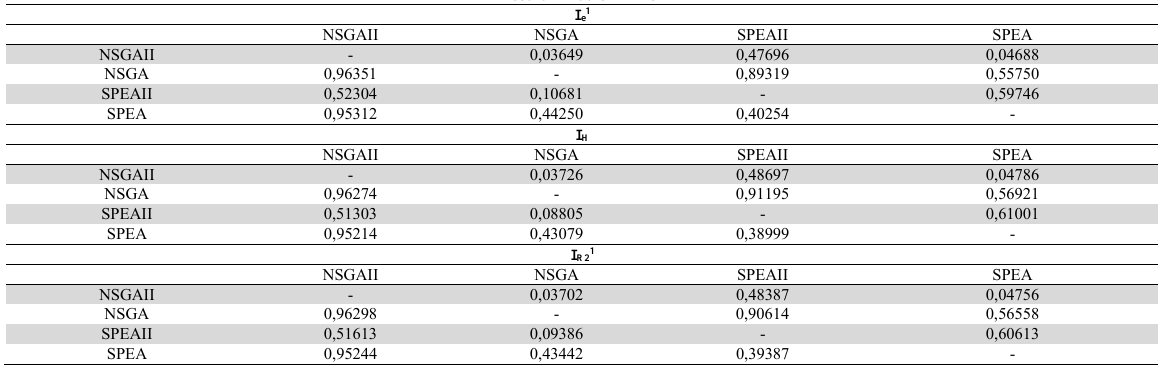
Table 9 Unary epsilon indicator, unary hypervolume indicator and R indicator (MF02)